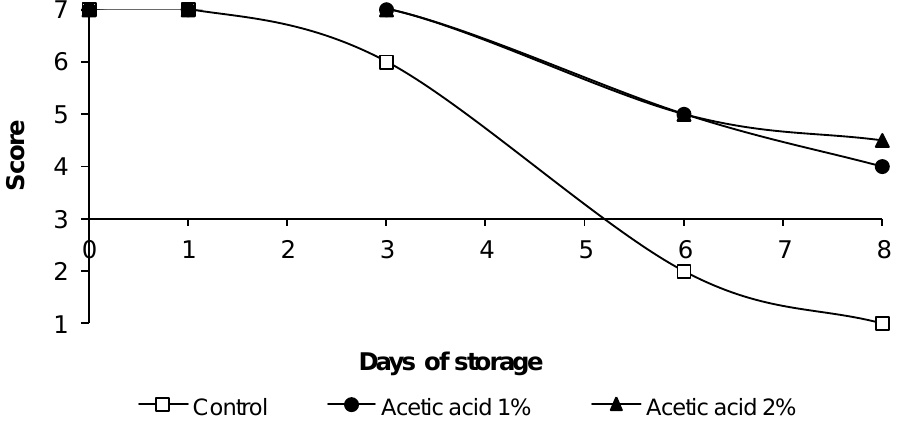
Figure 4. Overall appearance of chicken legs treated with lactic acid and acetic acid. The data are the mean values of six